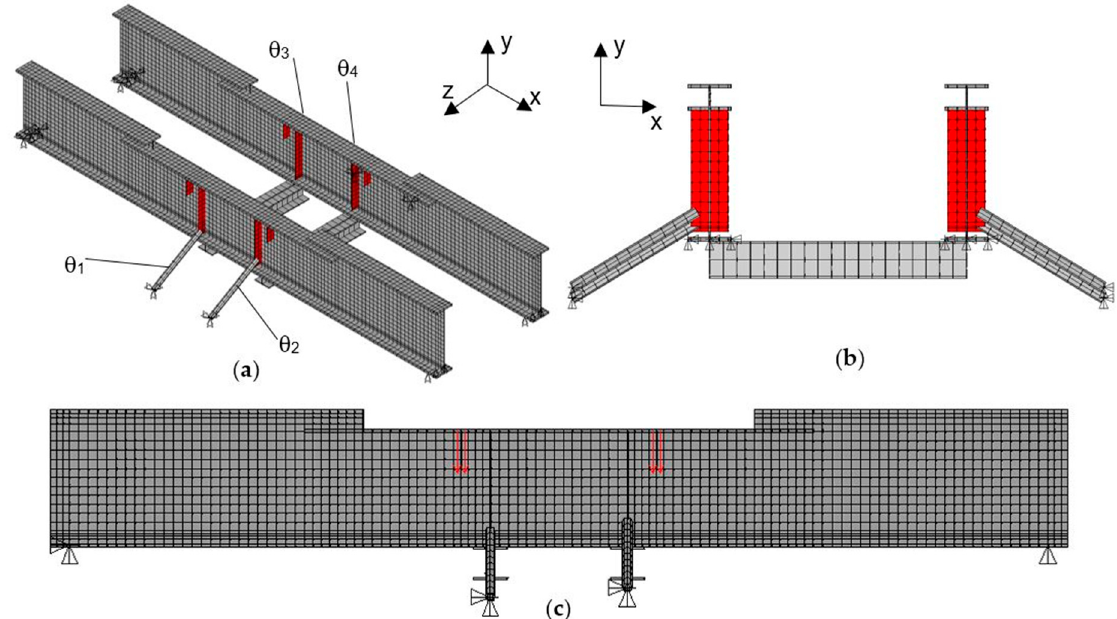
Figure 8. The developed global numerical model of the fatigue test of the NCHRP [47] program for fatigue strength assessment of web gap details: ( a ) global view, ( b ) longitudinal view, and ( c ) side view.